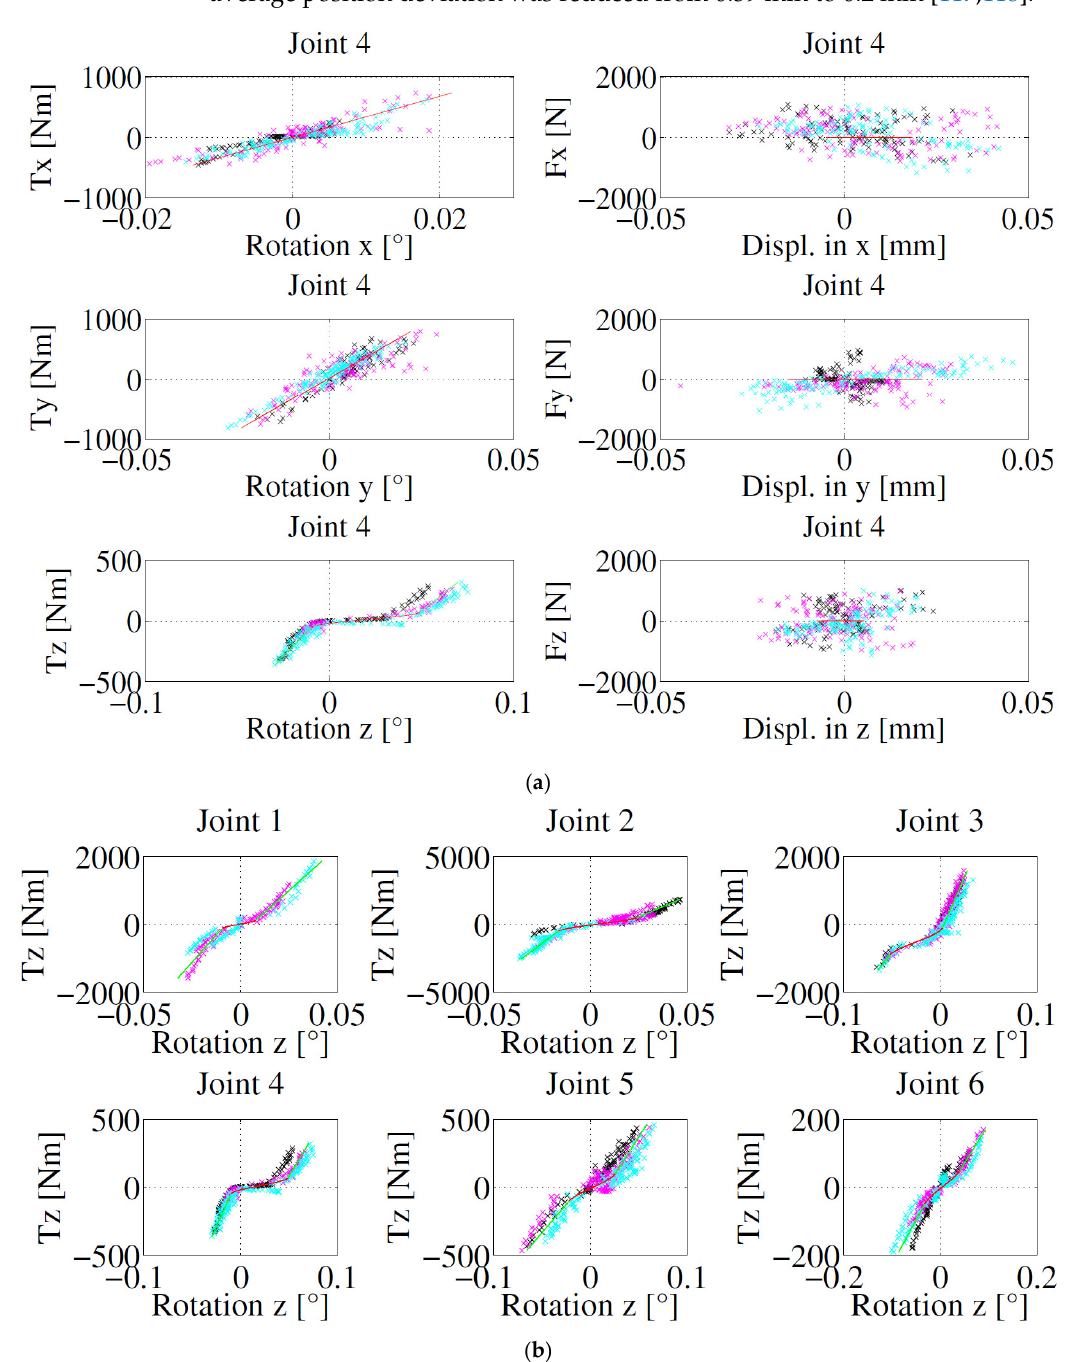
Figure 10. Diagram of the joint deformation distribution [117]: ( a ) 6D stiffness model of joint four and ( b ) rotational stiffness around the Z -axis of each joint. Four configurations are indicated by different colors in figure and lines are the result of linear least square fitting of experimental measurement data.